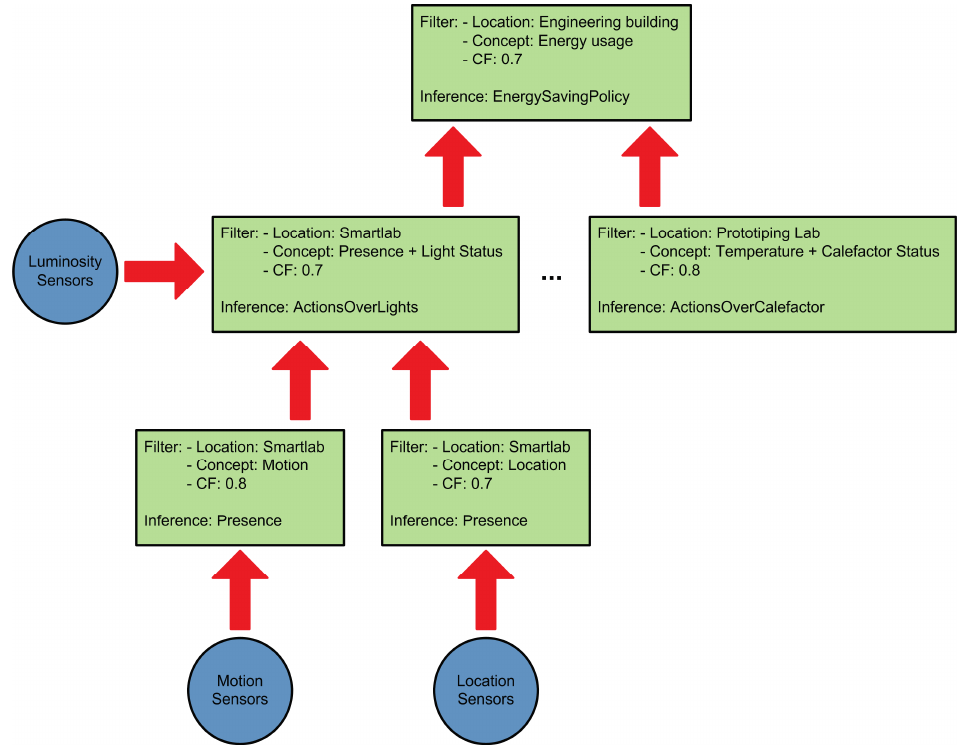
Figure 6. Reasoning hierarchy depicting the sensors (circles) and reasoning engines (squares) that take part in the inference